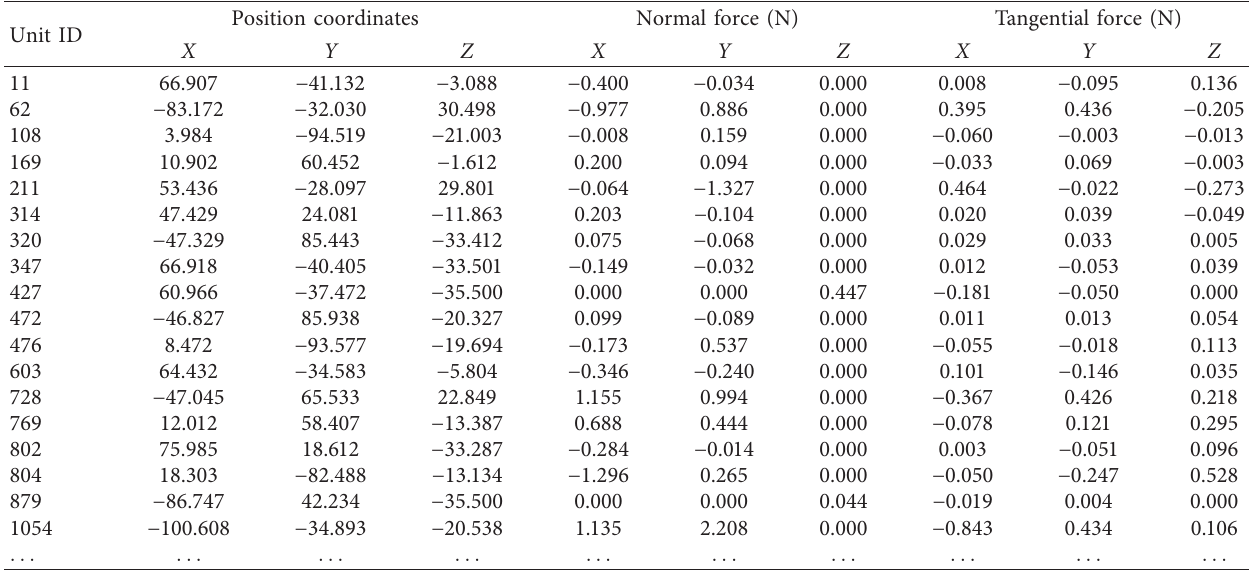
Table 2: Force of collision between particles and shell elements.